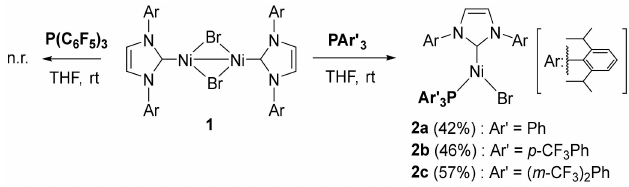
Scheme 2. Reaction of dinickel(I) complex 1 with